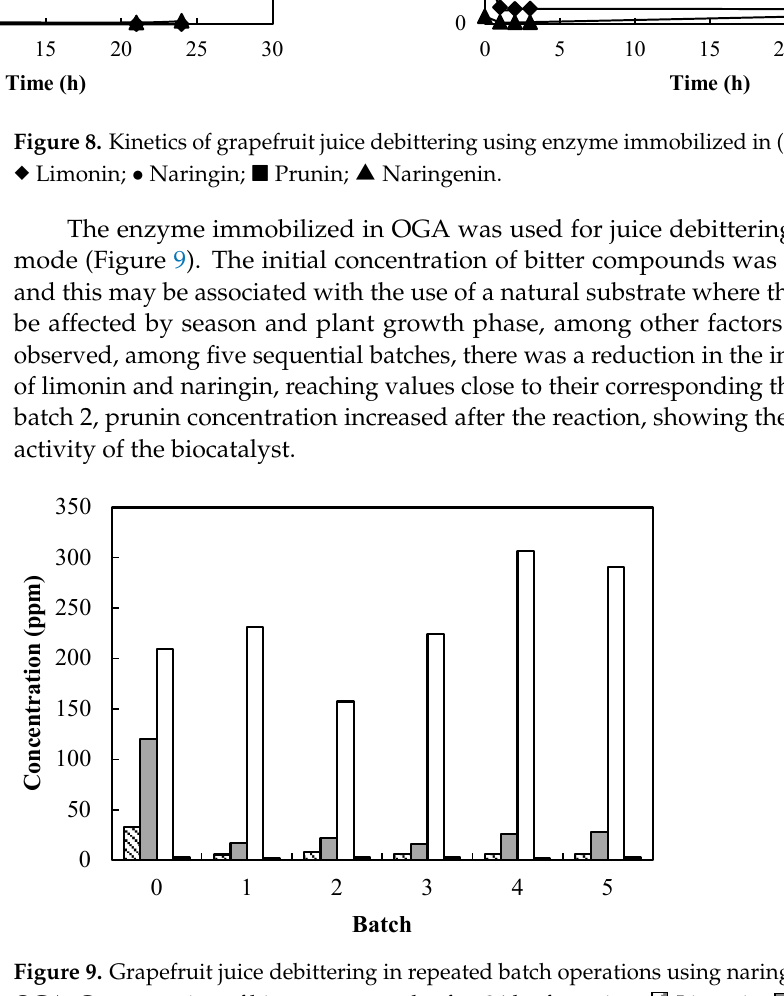
Figure 5. Effect of ( A , B ) pH and ( C , D ) temperature on the initial reaction rate of enzymes immobi ‐ lized in BGA ( A , C ) and OGA ( B , D ) using ∎ p NPG and ⯅ p NPR. 2.3. Debittering Grapefruit Juice First, the commercial enzymatic preparation (free enzyme) was used for grapefruit juice debittering. Figure 6 shows the kinetics of naringin, prunin, naringenin, and limonin concentrations. Naringin concentration decreased over time with a subsequent increase in prunin concentration, reflecting the α‐ L ‐ rhamnosidase activity. After 24 h of reaction, there was a 56% reduction in the initial concentration of naringin. Naringenin concentra ‐ tion increased after 24 h of reaction, indicating lower β‐ D ‐ glucosidase activity. Limonin was not affected by the action of the enzyme, as expected, and a 23% reduction after 24 h was observed in a control sample (data not shown), which may be explained by the de ‐ composition of the molecule.